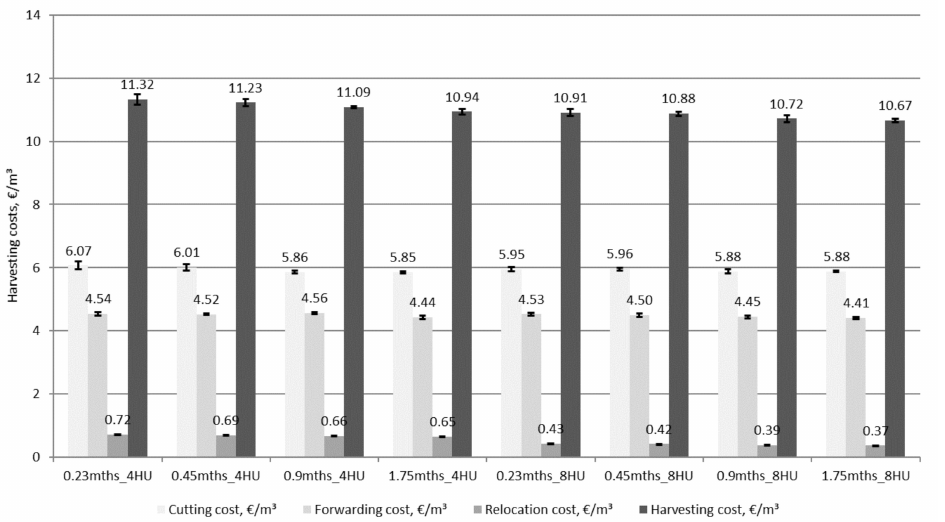
Figure 12. Harvesting costs for scenarios with a varying site reserve for the 4 and 8 HU options. Error bars represent 95% CI of 7 scenario replications.